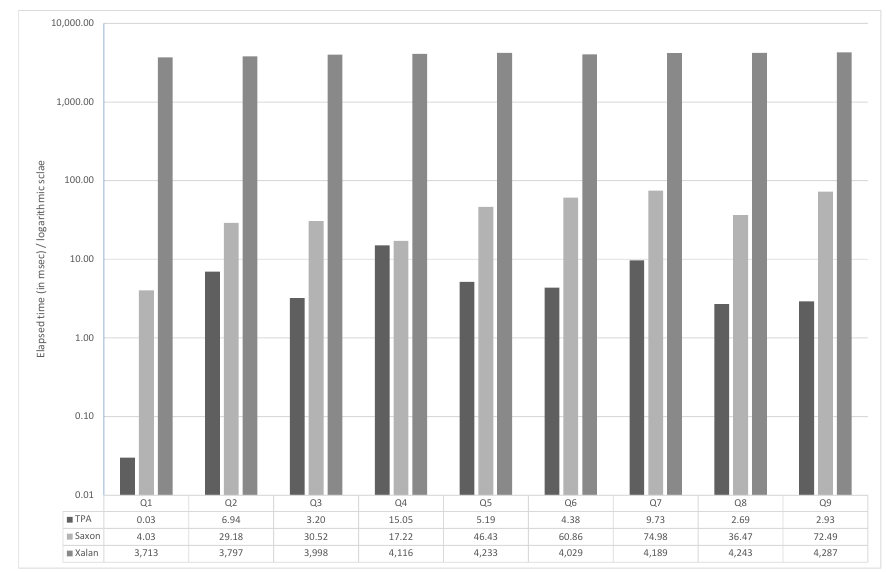
Figure 12. Performance comparison of TPA, Saxon and Xalan on DBLP dataset (logarithmic scale).